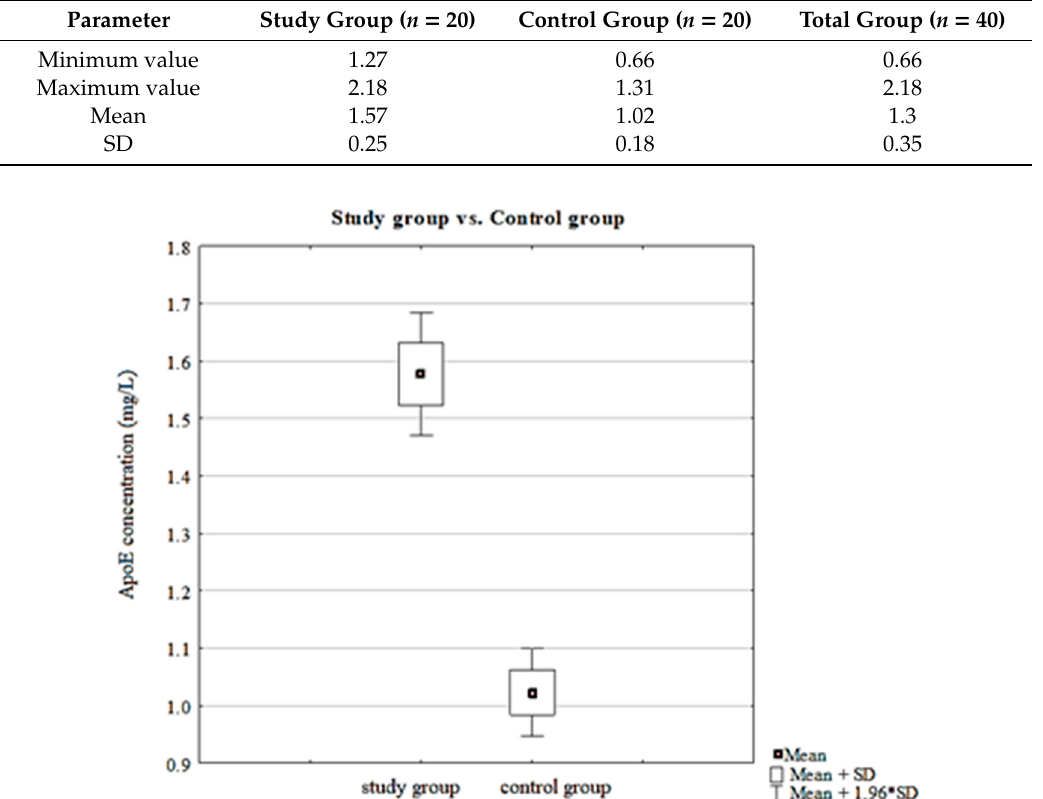
Table 1. Basic statistics of plasma ApoE measurement (data presented in mg/L).